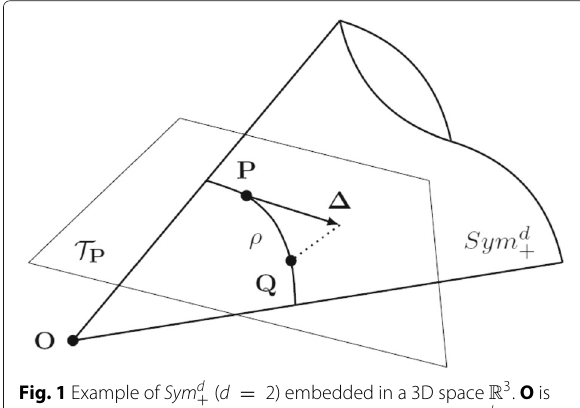
Fig. 1 Example of Sym d + ( d = 2) embedded in a 3D space R 3 . O is the origin. P and Q are the manifold points, i.e., P , Q ∈ Sym d + . T P is the tangent space at P . (cid:2) ∈ T P is thetangentvector whose projected point on the manifold is Q . The geodesic ρ is the shortest curve